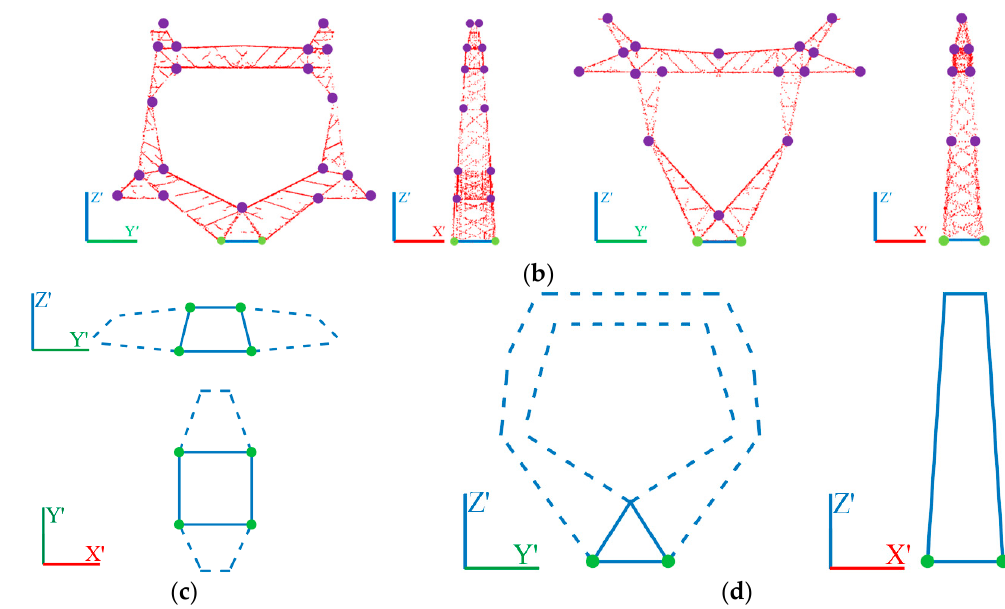
Figure 19. The complex structure: ( a ) Type-T complex structure; ( b ) Type-O complex structure; ( c ) Type-T template structure; ( d ) Type-O template structure.